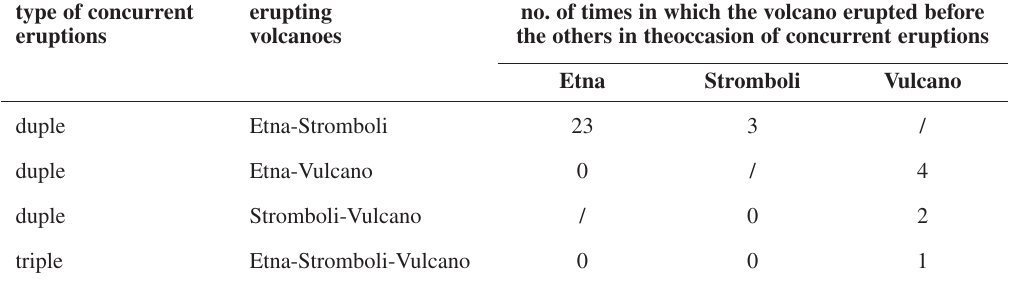
Table II. Time order of erupting volcanoes in the occasion of duple and triple concurrent eruptions between 1700 and 1993. Data are from Simkin and Siebert (1994). type of